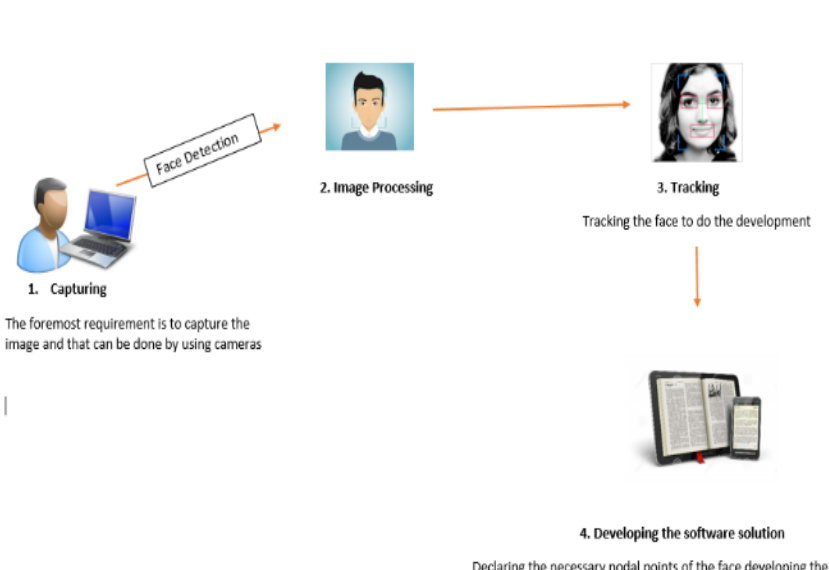
Figure 01: Top Level Design of the Proposed